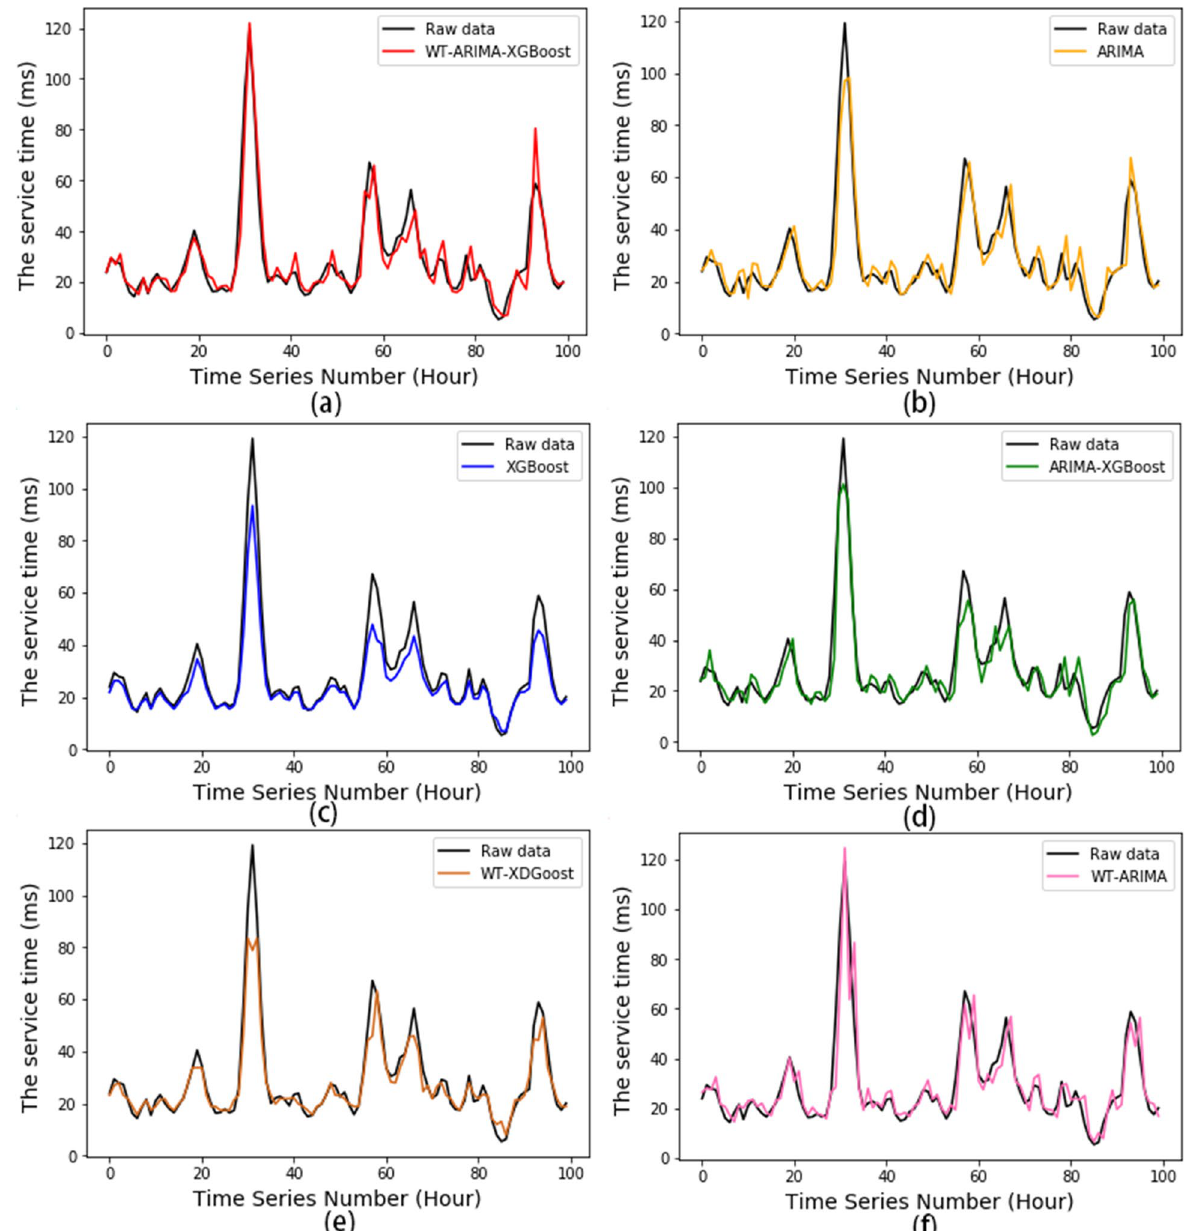
Fig. 4 Comparison of one-step prediction of layer actions response time using tested